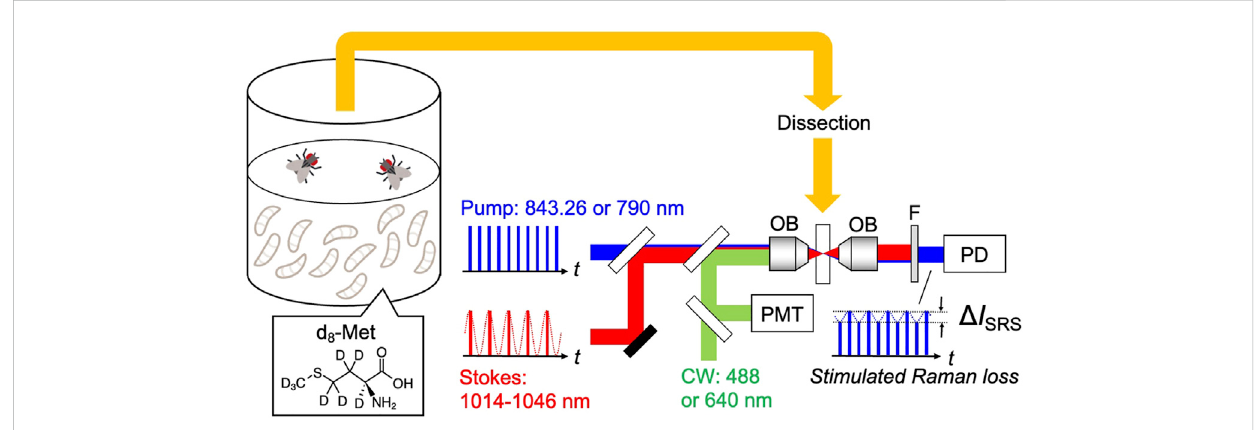
FIGURE 1 Schematic of the experiment: SRS and fl uorescence imaging of tissue, dissected from Drosophila raised on holidic medium containing deuterated methionine (d 8 -Met). OB: objective lens, F: short-pass fi lter, PD: photodiode, PMT: photomultiplier